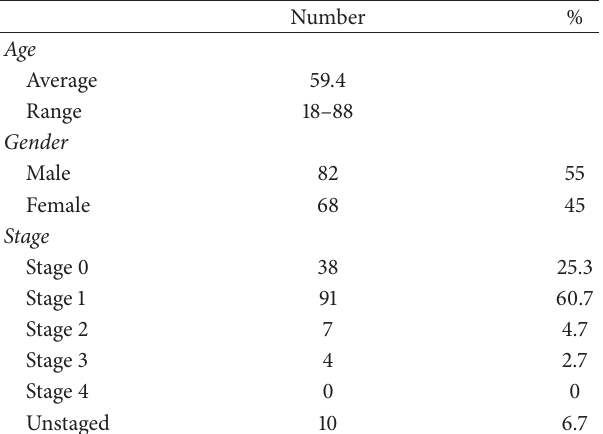
Table 1: Demographic